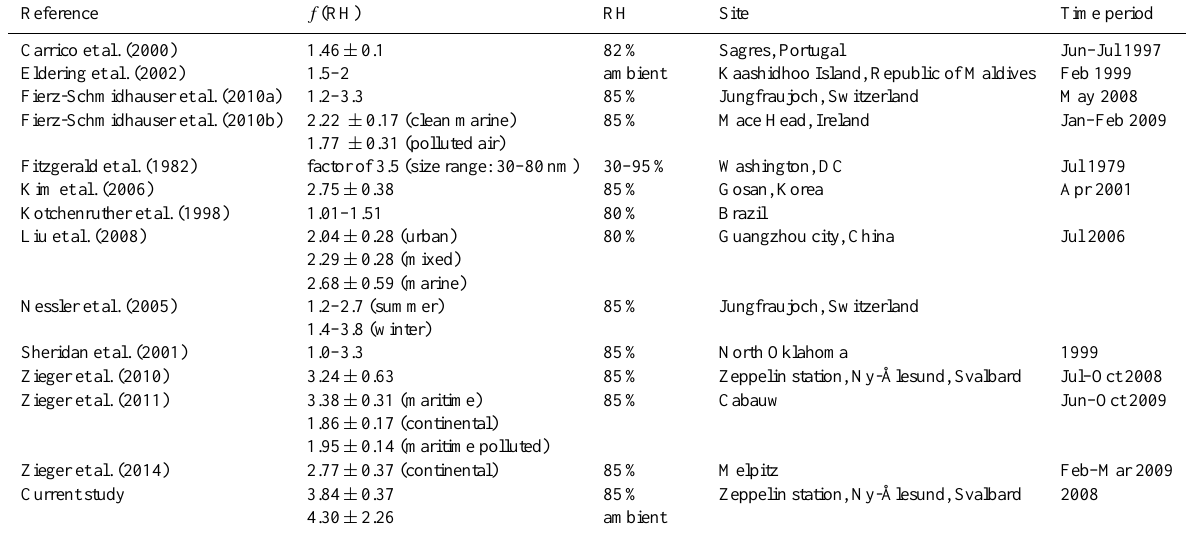
Table 1. Enhancement factors f (RH) reported in previous